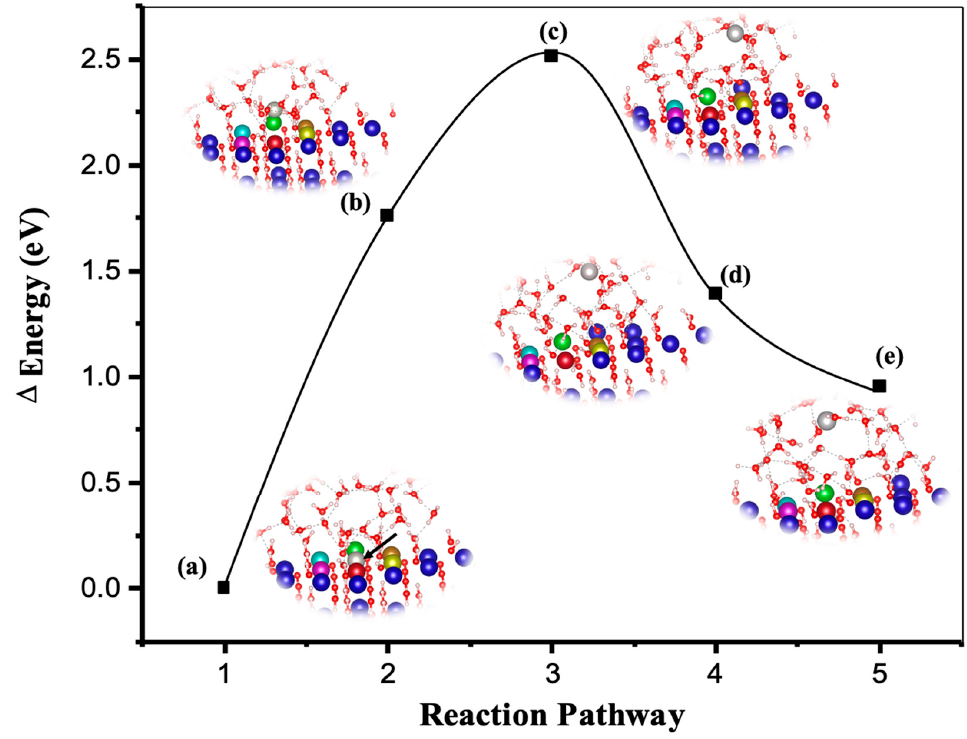
Figure 1. The DFT calculation of minimum energy pathway for Ca (light gray atom as shown with the arrow in the ground-state structure of ( a )) dissolution on the 001 or 001 facets for the first scenario in the presence of all neighbors. ( a , e ) show the initial and final ground-state structures, ( b – d ) also illustrate the energy pathway of portlandite as the Ca dissolved.